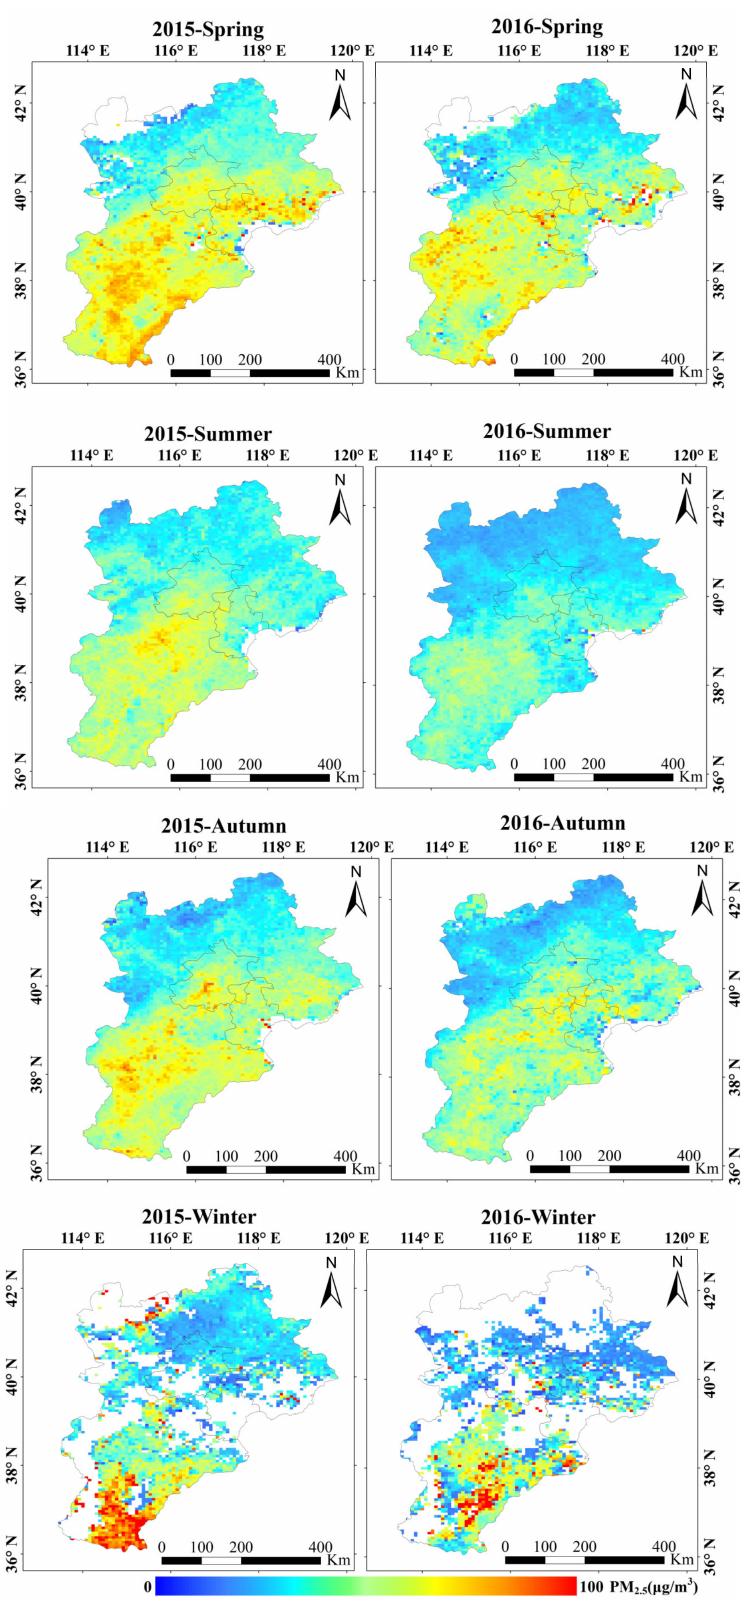
Figure 6. Spatiotemporal distributions of PM 2.5 concentrations in Beijing–Tianjin–Hebei